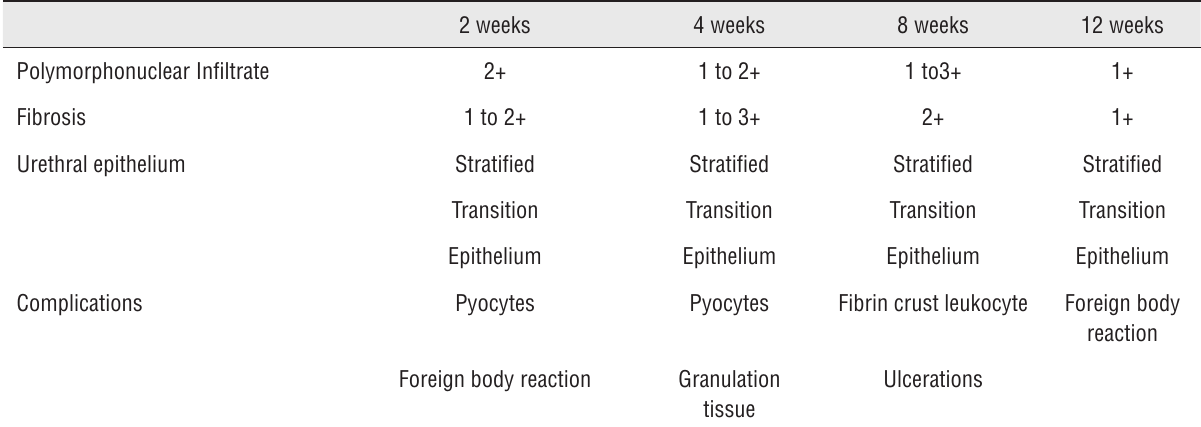
Table 2 - Microscopic findings of four groups in regards to inflammatory cells, fibrosis, epithelium and